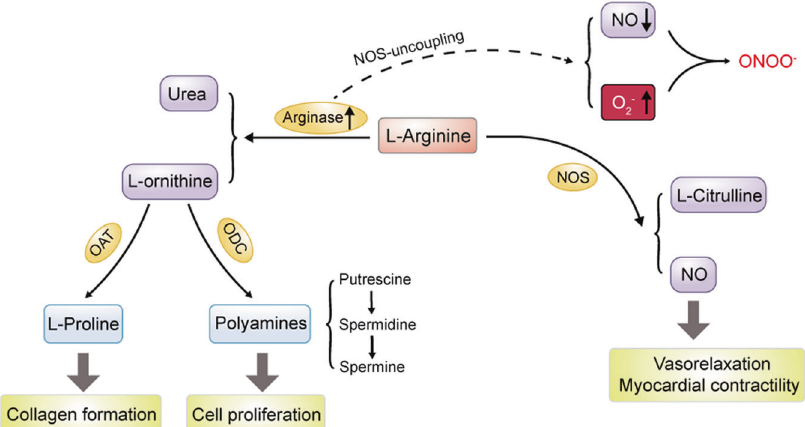
Fig. 1 Role of arginase metabolism in regulating polyamine and NO production. Arginase converts L-arginine to urea and L-ornithine that is further metabolized by ODC to polyamines including putrescine, spermidine, and spermine, which play a signi fi cant role in cell proliferation from cardiovascular system, or is converted by OAT to L-proline that is essential for collagen formation. Meanwhile, L-arginine also serves as substrate of the enzyme NOS which speci fi cally catalyzes L-arginine to L-citrulline and NO which can promote vasorelaxation and myocardial contractility. The increase of arginase may cause NOS-uncoupling, which contributes to decreased NO production and increased O 2 − and ONOO − . ODC ornithine decarboxylase, OAT ornithine aminotransferase, NOS nitric oxide synthase, O 2 − superoxide anion, NO nitric oxide, ONOO −